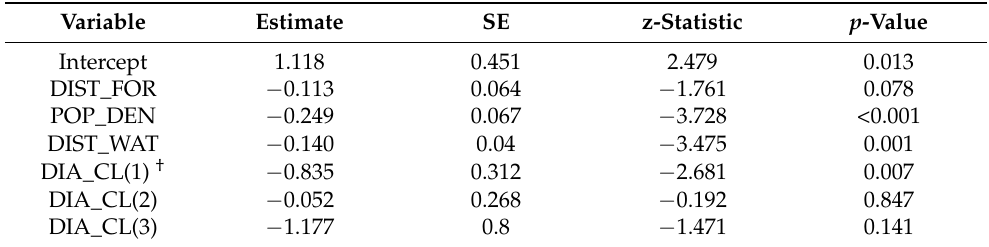
Table 2. Summary of logistic regression analysis. The notation of variables was described in Table 1 (SE: standard error).